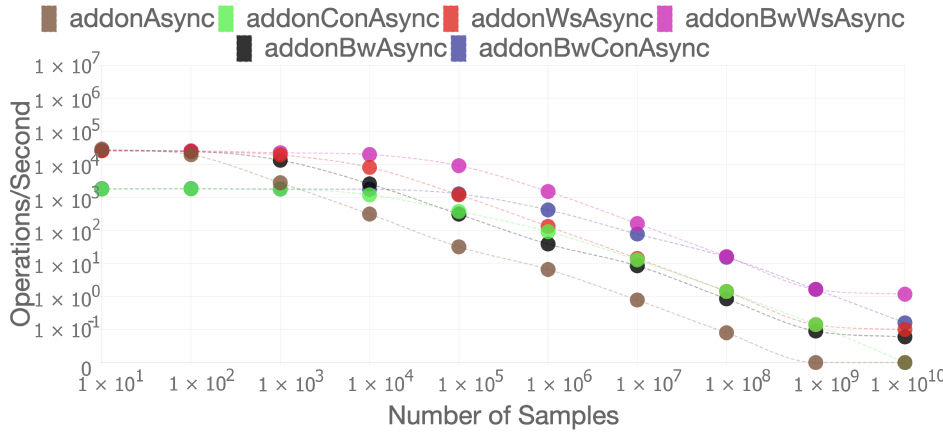
Figure 8. Average operations per second of asynchronous implementations in